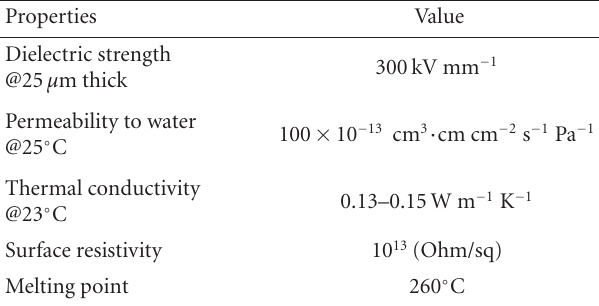
Table 3: Properties of polyethylene terephthalate.